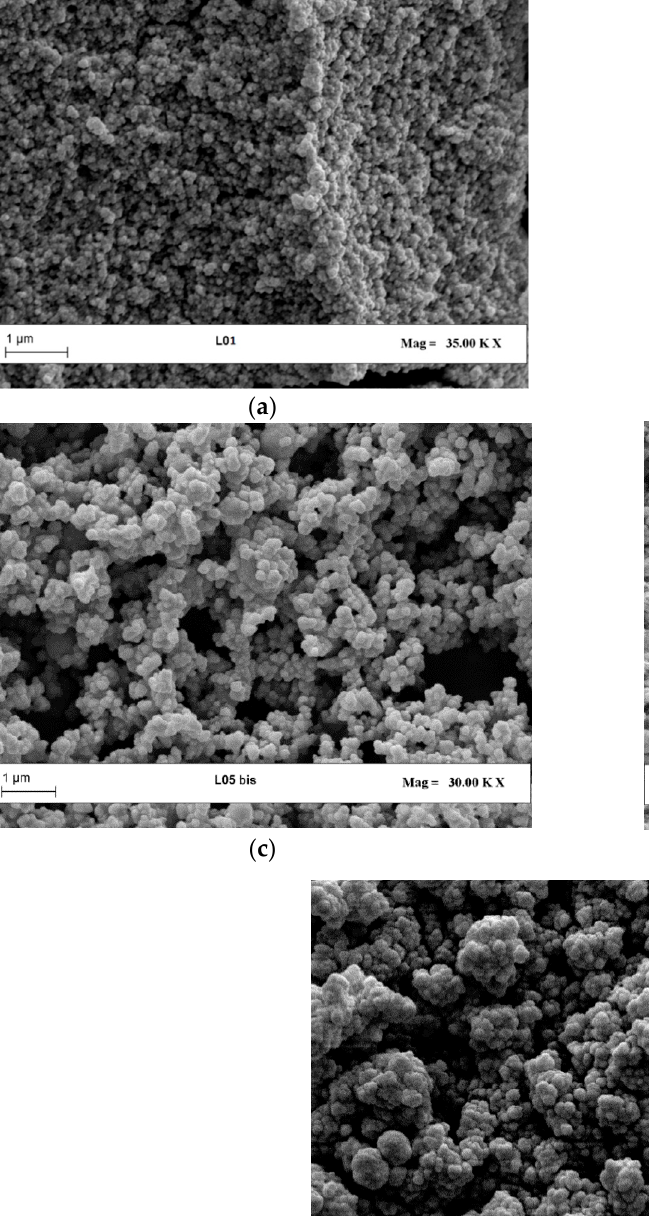
Figure 5. Drug release test comparison from liposomes, as an effect of liposomes produced at dif- ferent temperatures. The drug release of the experiment produced at 35 °C ended in about 4.5 days, with a significant delay time of 0.8 days before liposomes started to release lutein. A similar behavior was registered for drug release from liposomes produced at 40 °C, where the initial delay was about 0.6 days and it released all the drug content in 3 days. The third